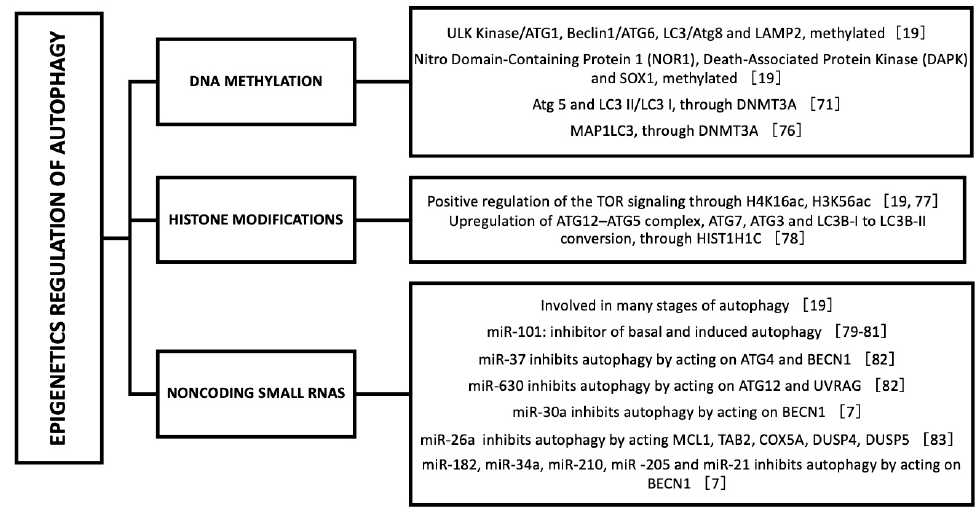
Figure 3. Epigenetic mechanisms involved in autophagy.